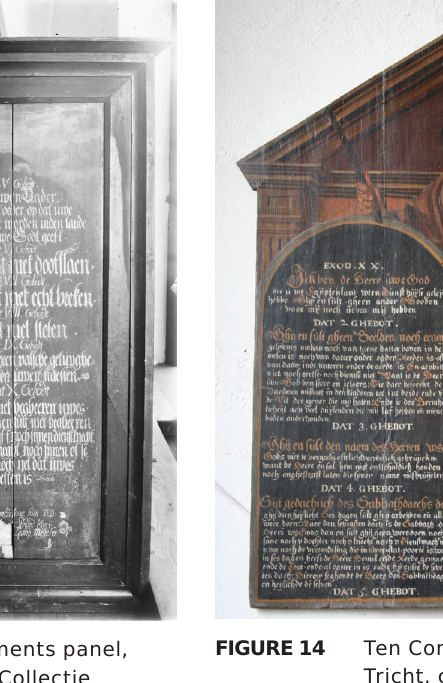
FIgure 14 Ten Commandments panel, Tricht, c.1575-1650, photo archive Regnerus Steensma.